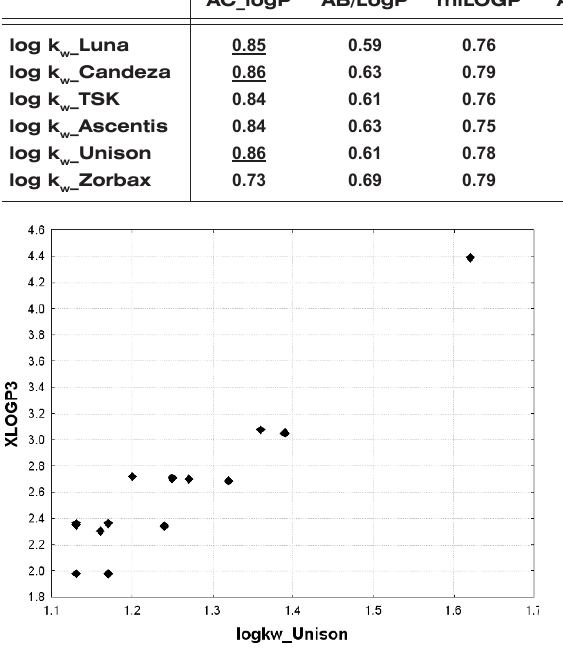
Figure 2. Example of correlation between determined (logkw_Unison) and calculated lipophilicity (XLOGP3) for imidazoacridinones with statistical significance level p = 1×10 -7